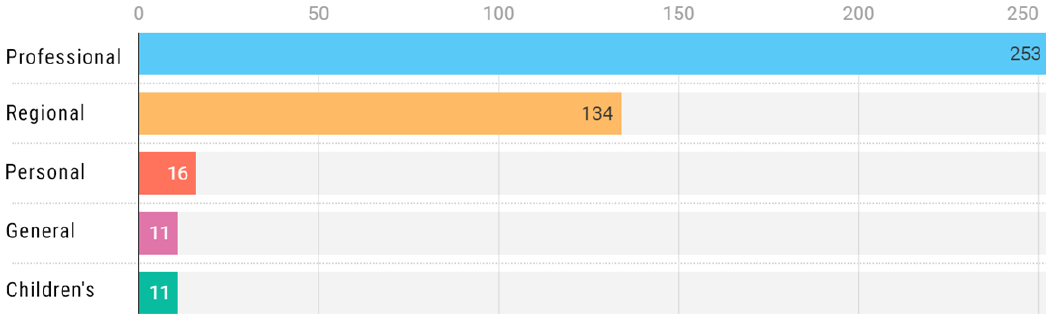
Figure 1: The number of Ukrainian encyclopedic editions in the bibliographic online index Corpus of Ukrainian Encyclopedias [7].